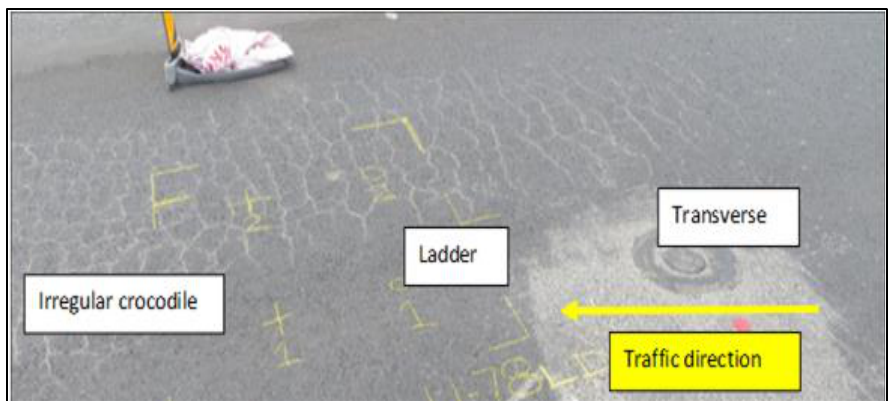
Figure 3. Changes in the pattern of cracks of the second kind.